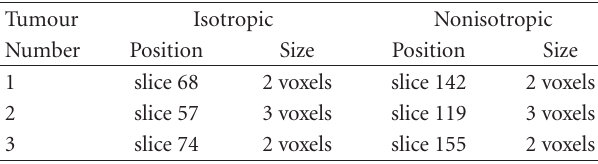
Table 1: Tumours characteristics for the second data set. Tumour Isotropic